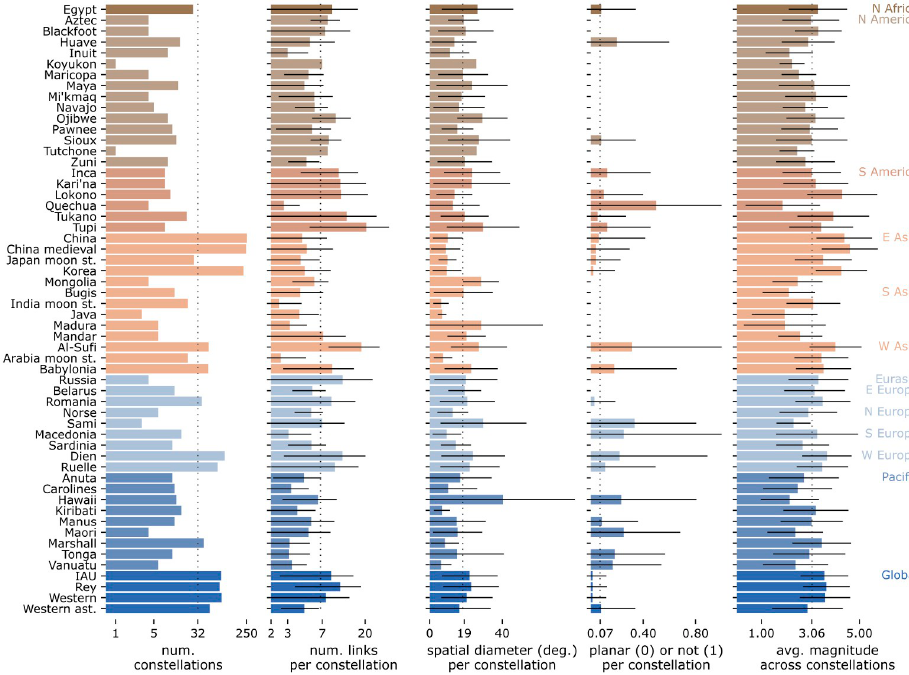
Fig 3. Constellations features aggregated per sky culture. The culture size (constellation count) is on the left. Four constellation features ( s 1 , s 12 , s 16 , and s 17 ) are then shown via their averages and standard deviations per culture. The global average of each statistic is marked with a dotted line. The horizontal scales for the first two statistics are logarithmic, and the rest linear.